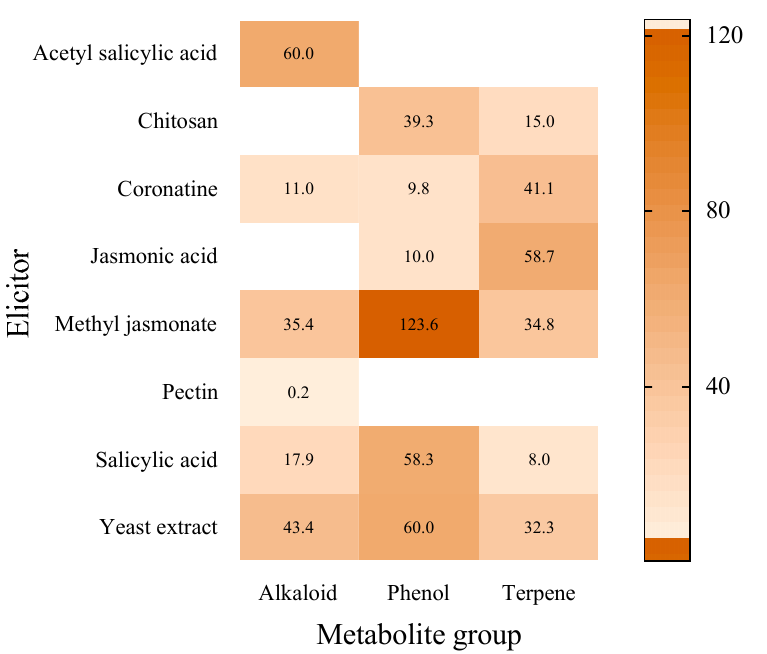
Figure 2. Maximum production (mg/g DW) value of each metabolite group in hairy roots according to the elicitor used, from 2010 to 11 January 2022.